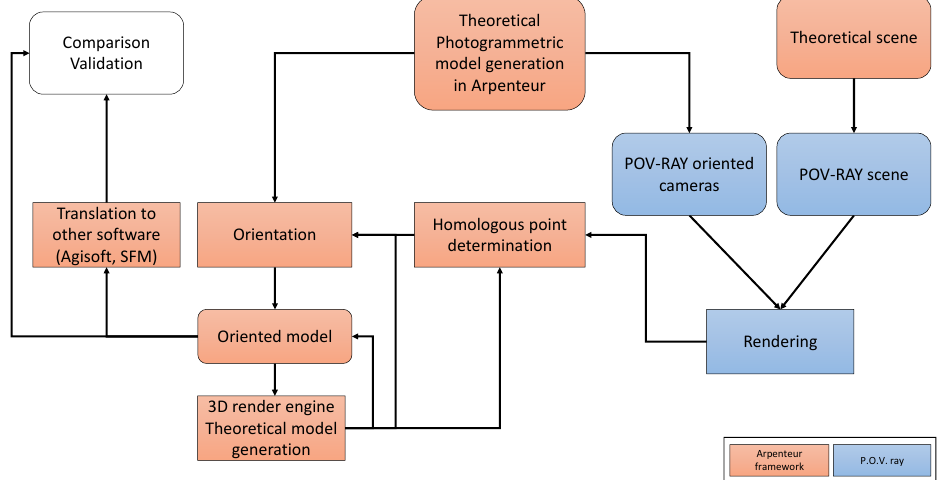
Figure 1. synoptic schema of theoretical model generation